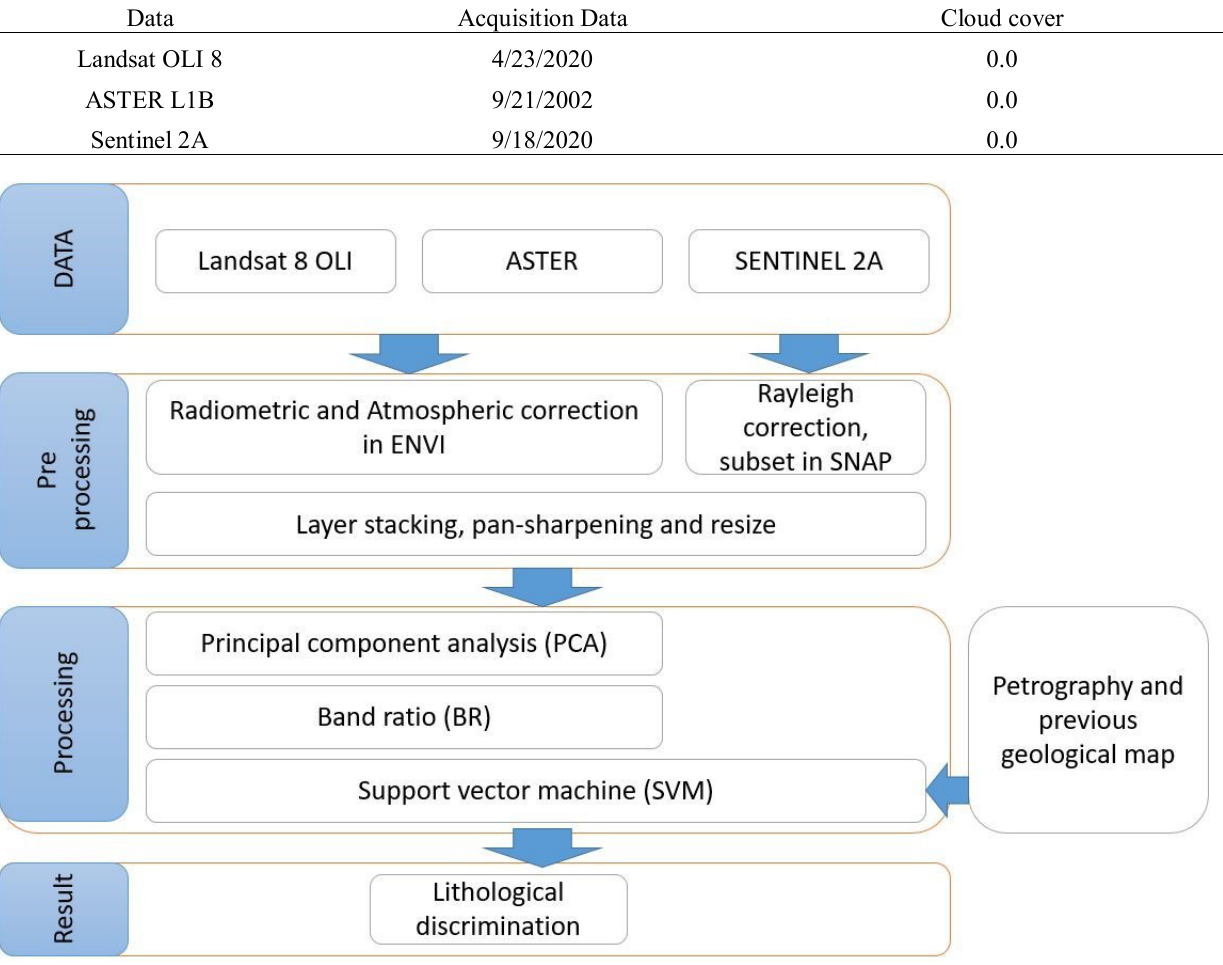
Fig. 4. Flowchart of the